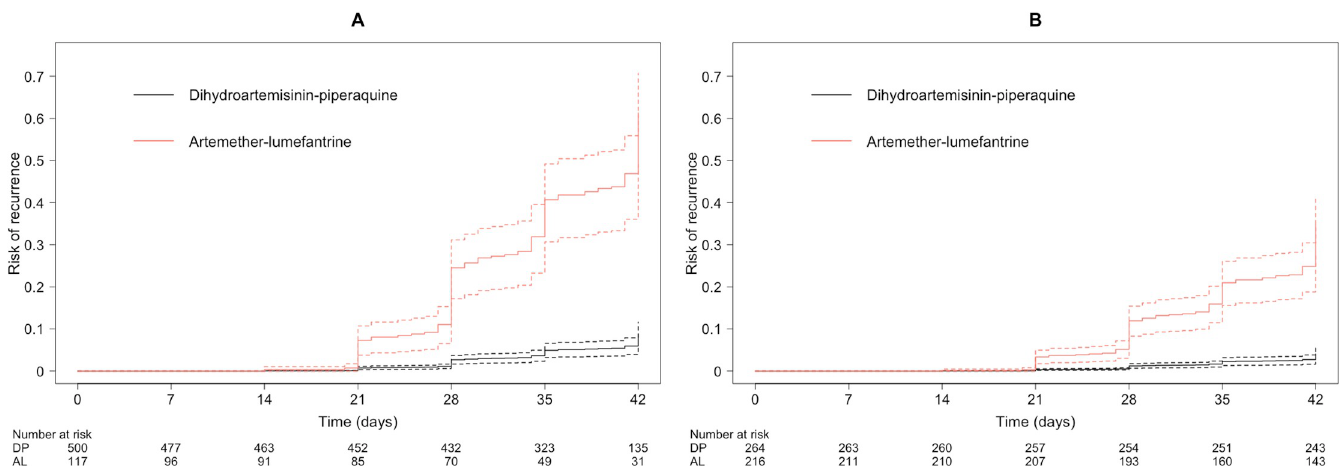
Fig 2. Risk of recurrence (solid line, estimate; dashed lines, limits of 95% CI) adjusted for age, gender, relapse periodicity, baseline haemoglobin, and baseline parasitaemia in patients receiving DP or AL alone in (A) short-periodicity regions ( p < 0.001) and (B) long-periodicity regions ( p < 0.001). Assumes zero effect from study site; p -values derived from Cox model. AL, artemether-lumefantrine; CI, confidence interval; DP, dihydroartemisinin-piperaquine.